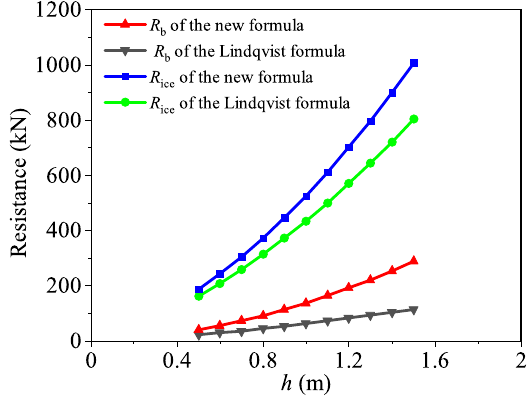
Figure 8. Variation of resistances with the ice